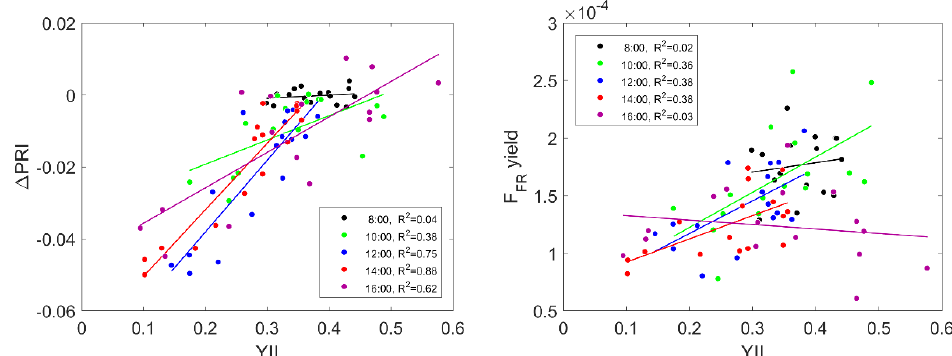
Figure 10. The relationship between ∆ PRI F FR yield and YII. To explore the correlation between these data at different times, linear fitting was conducted every two hours.